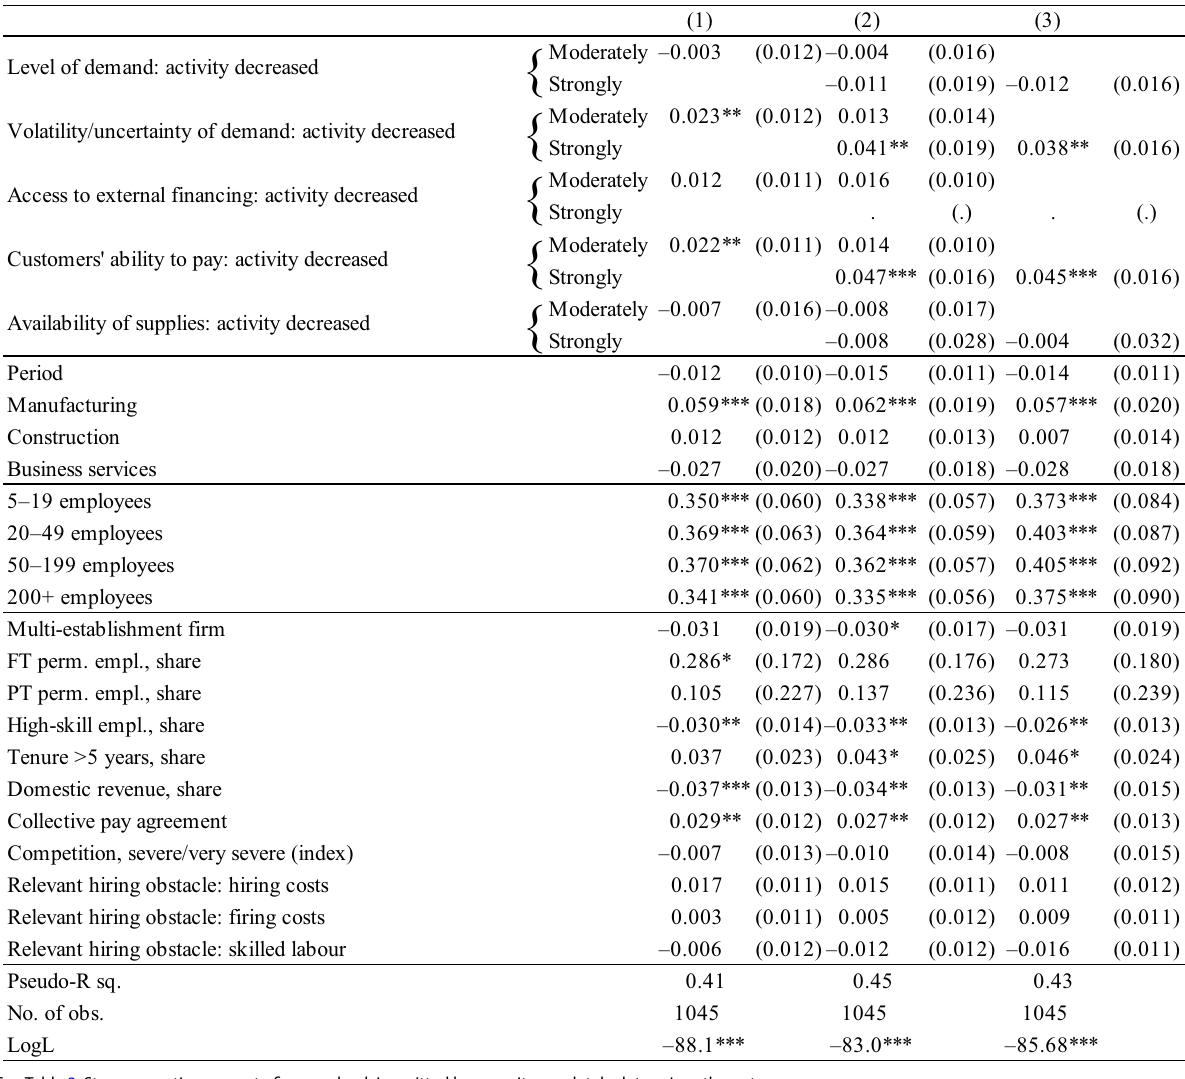
Table 9 Logit estimates for firms whose application for short‑time work was accepted (and used), marginal